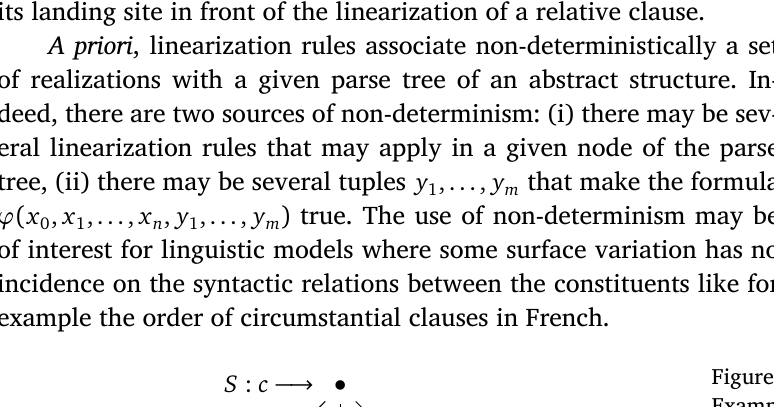
Figure 5: Example of a guided